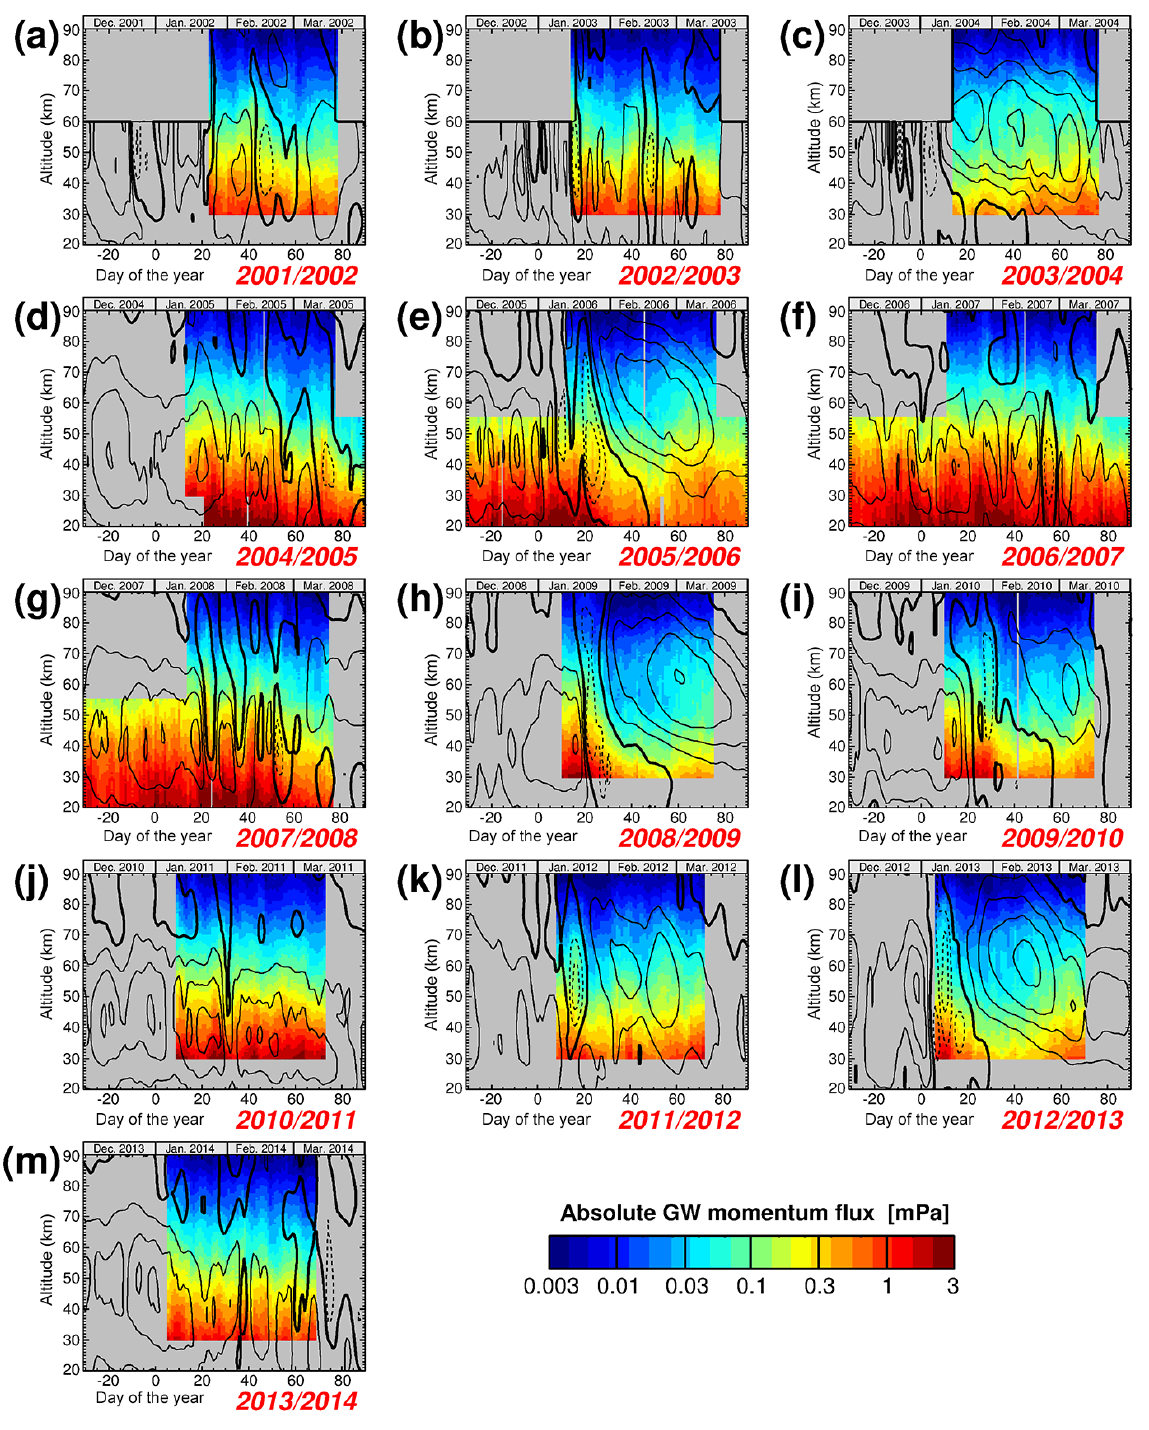
Figure 5. Same as in Fig. 3, but for gravity wave absolute momentum fluxes at 60–80 ◦ N. Momentum fluxes are given in mPa on a logarithmic color scale. Like in Fig. 1, overplotted contour lines indicate zonal average zonal winds at 60–80 ◦ N in steps of 20ms − 1 .